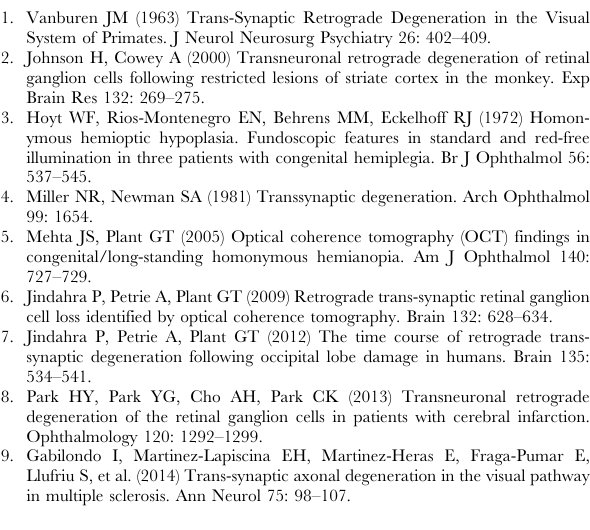
Table S1 Clinical, OCT and VF raw data from